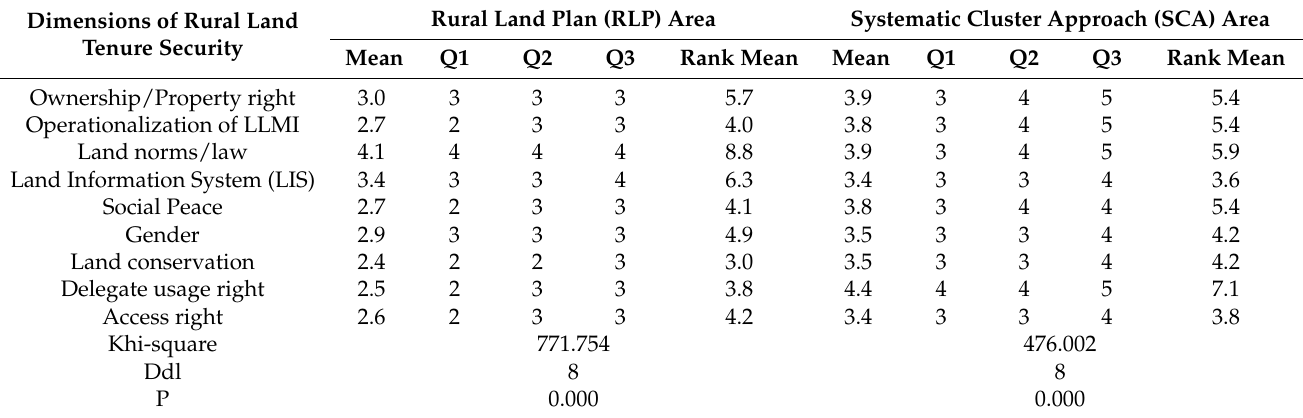
Table 4. Contributions of SCA and RLP approach to rural land tenure